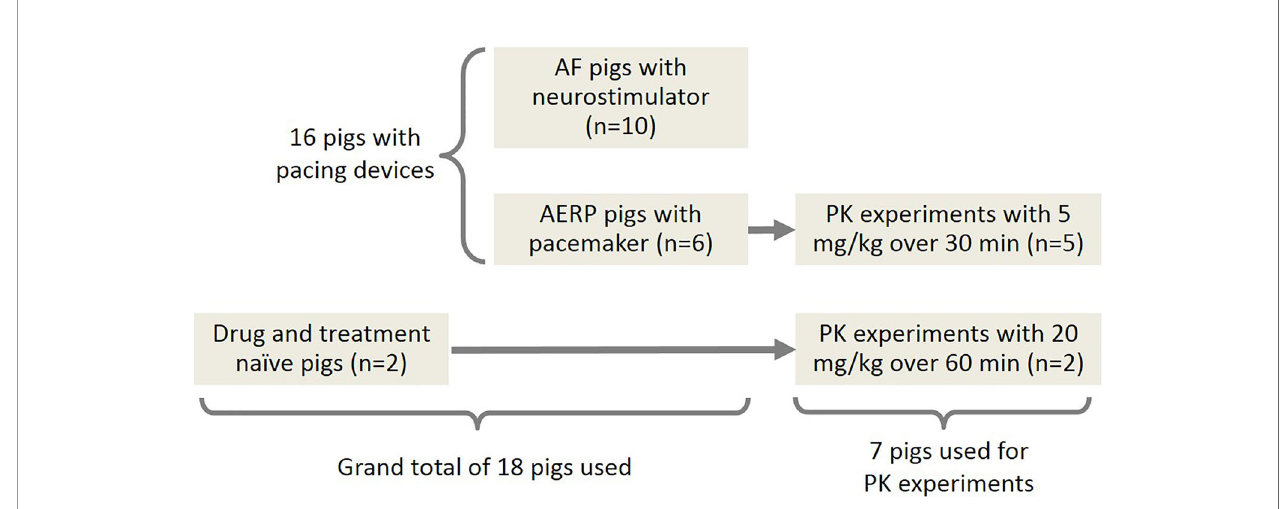
FIGURE 1 | Overview of the experiments and the participating pigs. A-TP pigs: pigs subjected to AF induction by atrial tachy-pacing; AERP pigs: pigs for determination of the